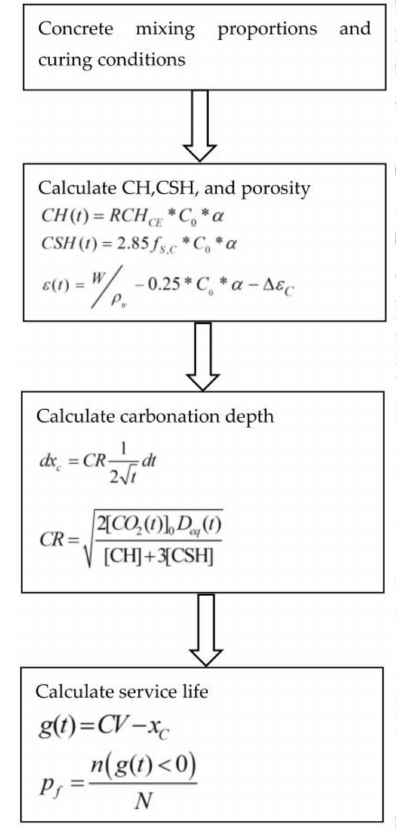
Figure 1. Flowchart of proposed model. CH: calcium hydroxide; RCH CE : mass of CH from the hydration of 1-unit mass cement; C 0 : cement content; α : degree of cement hydration; CSH: calcium silica hydrate; f S , C : silica weight fraction in cement; ε : porosity of concrete; W : water content in concrete; ρ W : density of water; ∆ ε C : porosity reduction due to the carbonation of concrete; dx c : increase of carbonation depth in time increment dt ; CR : carbonation rate parameter; D eq : equivalent diffusion coefficient; g ( t ) : durability failure criteria; CV : cover depth of concrete; p f : probability of carbonation durability failure; n ( g ( t ) < 0 ) : number of carbonation durability failures out of a total N